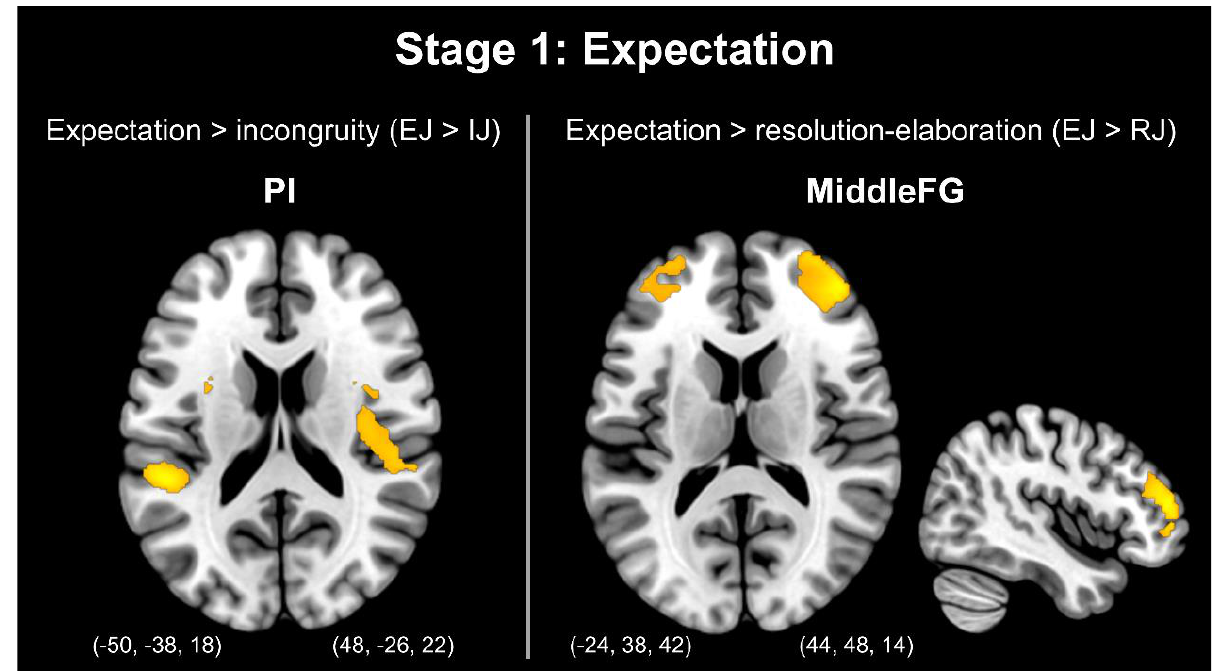
Figure 2. Stage 1: Expectation. Note: PI = posterior insula; MiddleFG = middle frontal gyrus.